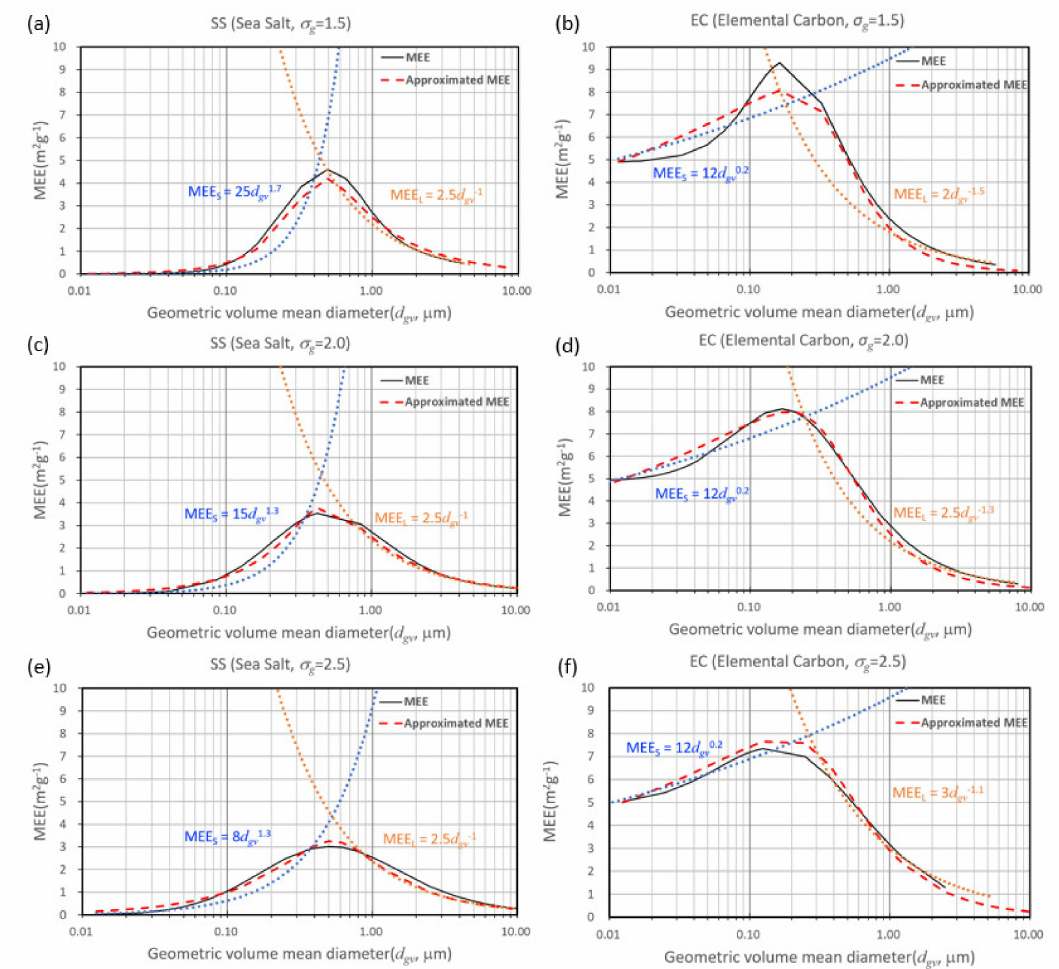
Figure 5. Same as Figure 4, but for sea salt (SS, left column ) and elemental carbon (EC, right column